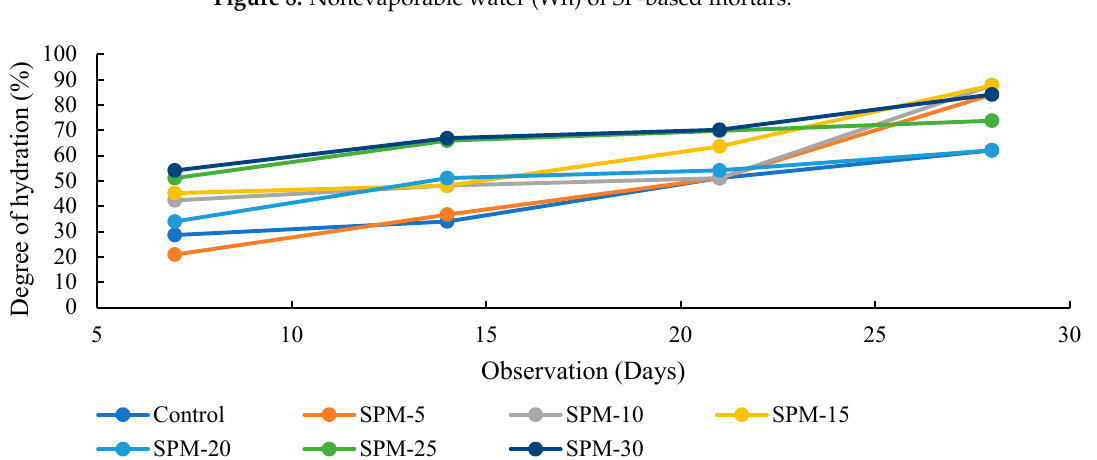
Figure 9. Degree of hydration of SP-based mortars.